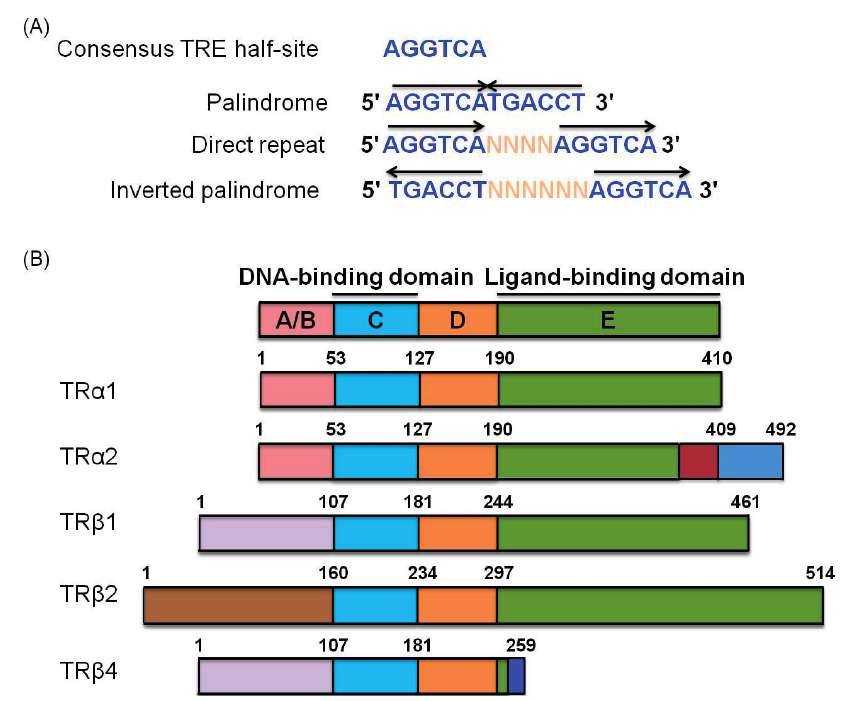
Figure 1. Schematic representation of consensus TRE half-sites and TR α and TR β isoforms. ( A ) The consensus half-site of TRE is divided into palindrome, direct repeat and inverted palindrome sequences. Each half-site presents different orientations and nucleotide spacing (N: nucleotide; arrows: half-site orientation); ( B ) TR α 1 and TR β 1 are generated by alternative splicing and promoter usage from TR α and TR β . TR isoforms contain several functional domains, including an amino terminal region (A/B domain), conserved DNA-binding domain (DBD) (C domain), hinge region that links the DBD and ligand-binding domains (LBD) (D domain), and LBD responsible for receptor dimerization (E domain).